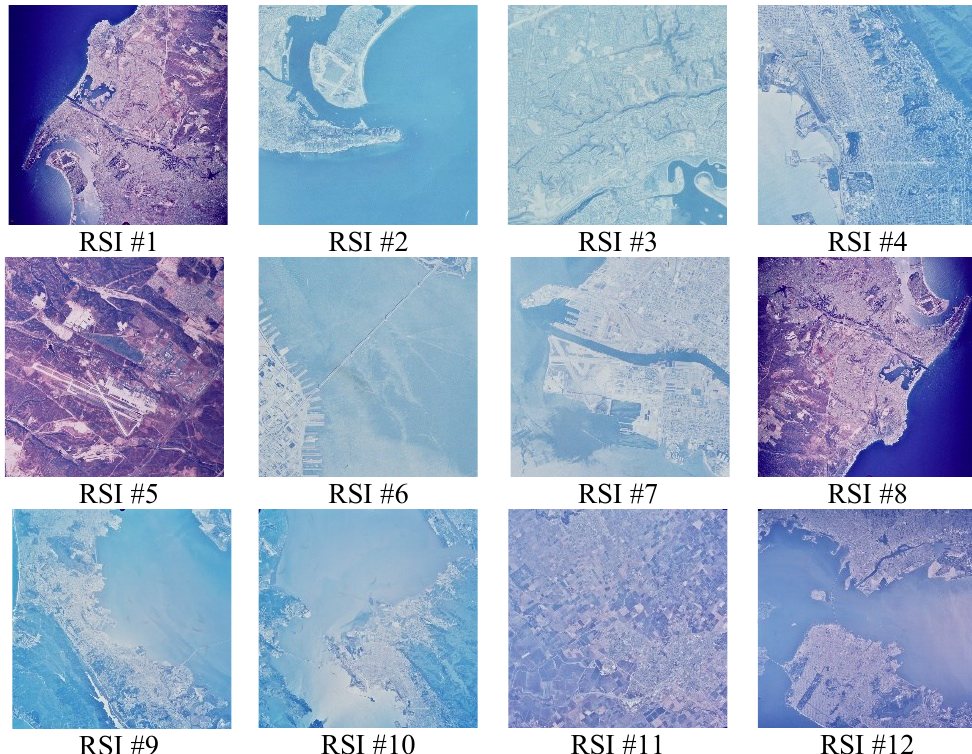
Figure 5. The original images from the basic image set.